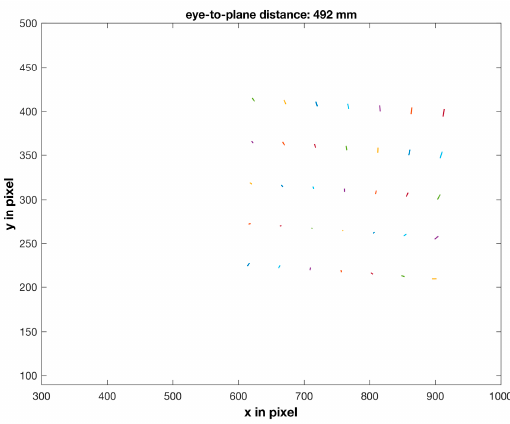
Figure A4. Map of disparities for a target plane placed at 492 mm from the observer.